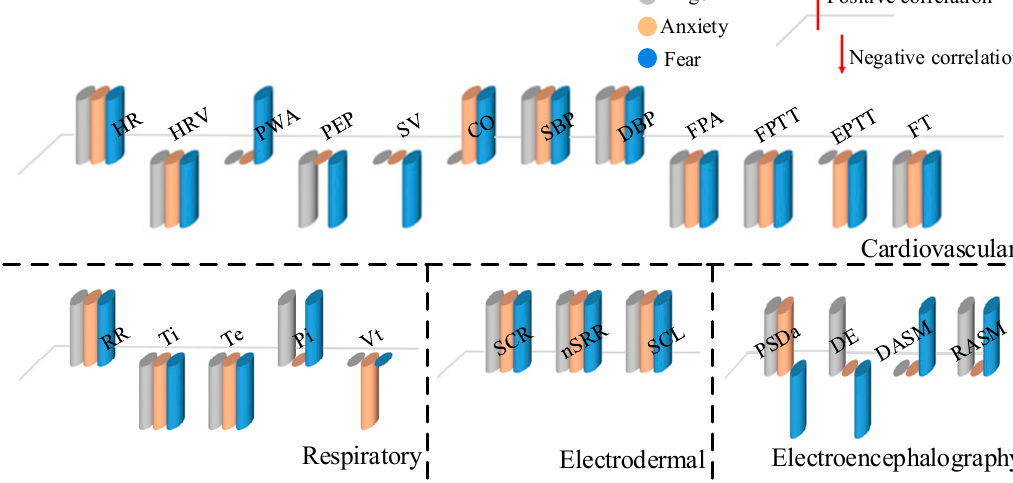
Figure 3. The correlation between physiological signal characteristics and three negative emotions.